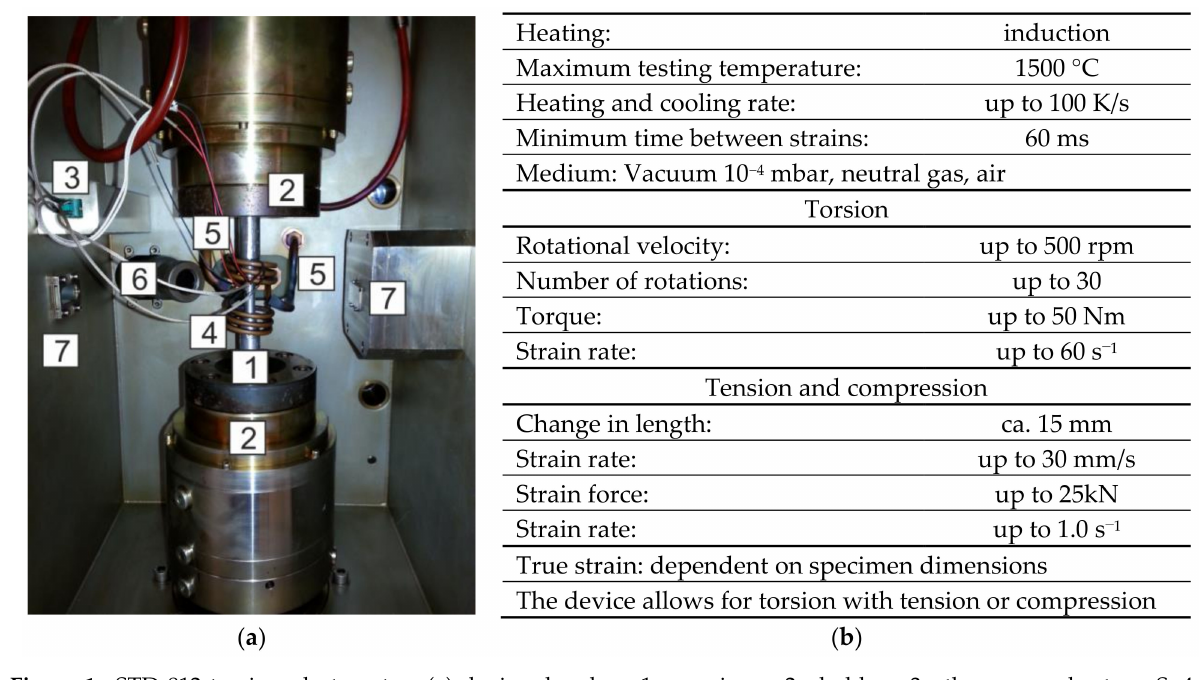
Figure 1. STD 812 torsion plastometer: ( a ) device chamber: 1—specimen, 2—holders, 3—thermocouples type S, 4— induction solenoid, 5—cooling system jets, 6—pyrometer and 7—sensors for laser measurement of specimen diameter; ( b ) basic specification.